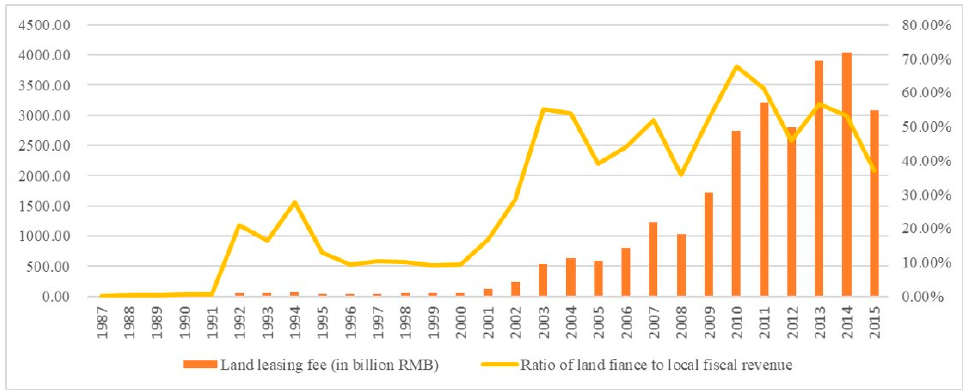
Figure 3. Ratio of land finance to local fiscal income (1987–2015). Data Source: 1987–1999 from Zhang [56] , 2000–2015 from China Land Resource Yearbook , National Bureau of Statistics of China and Ministry of Finance. The related data (1978–1986) cannot be found either in academic publications or in official statistics.